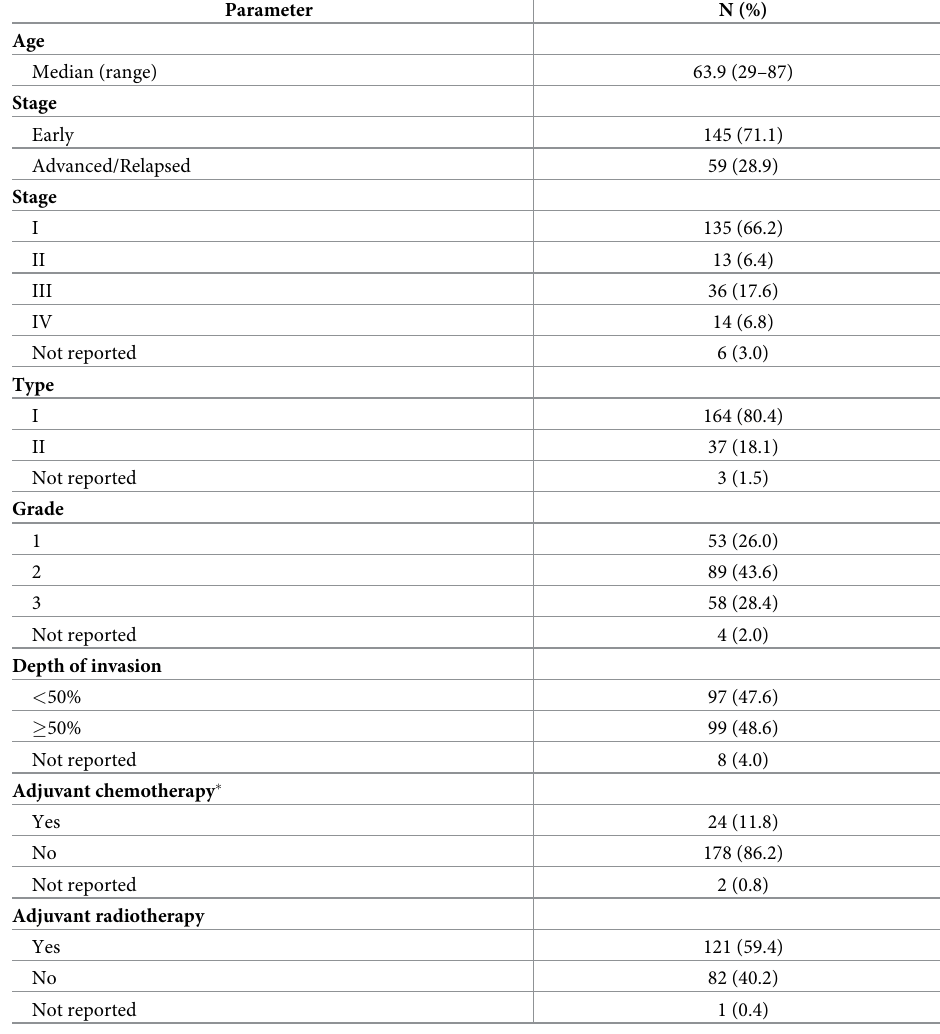
Table 1. Selected patient and tumor characteristics, N =